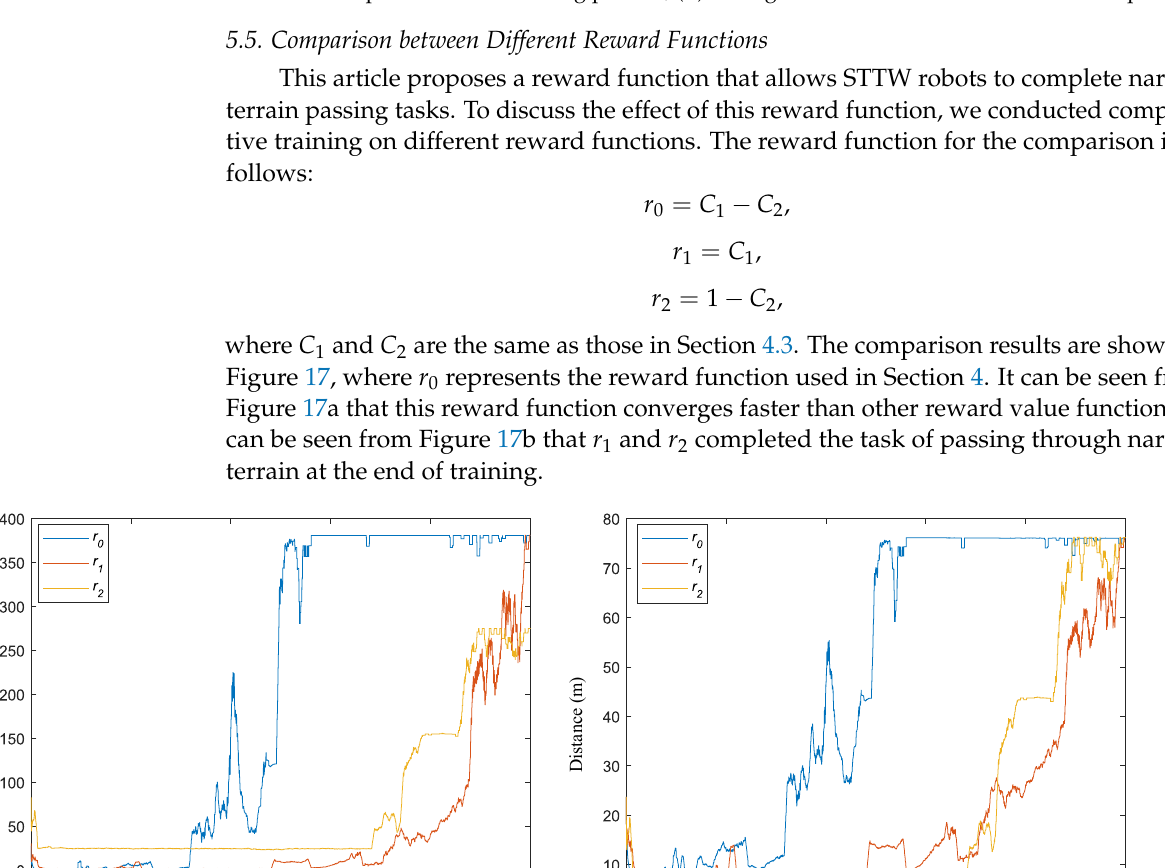
Figure 16. Comparison between different reinforcement learning control methods: ( a ) average reward of the last 30 episodes in the training process; ( b ) average maximum distance of the last 30 episodes.